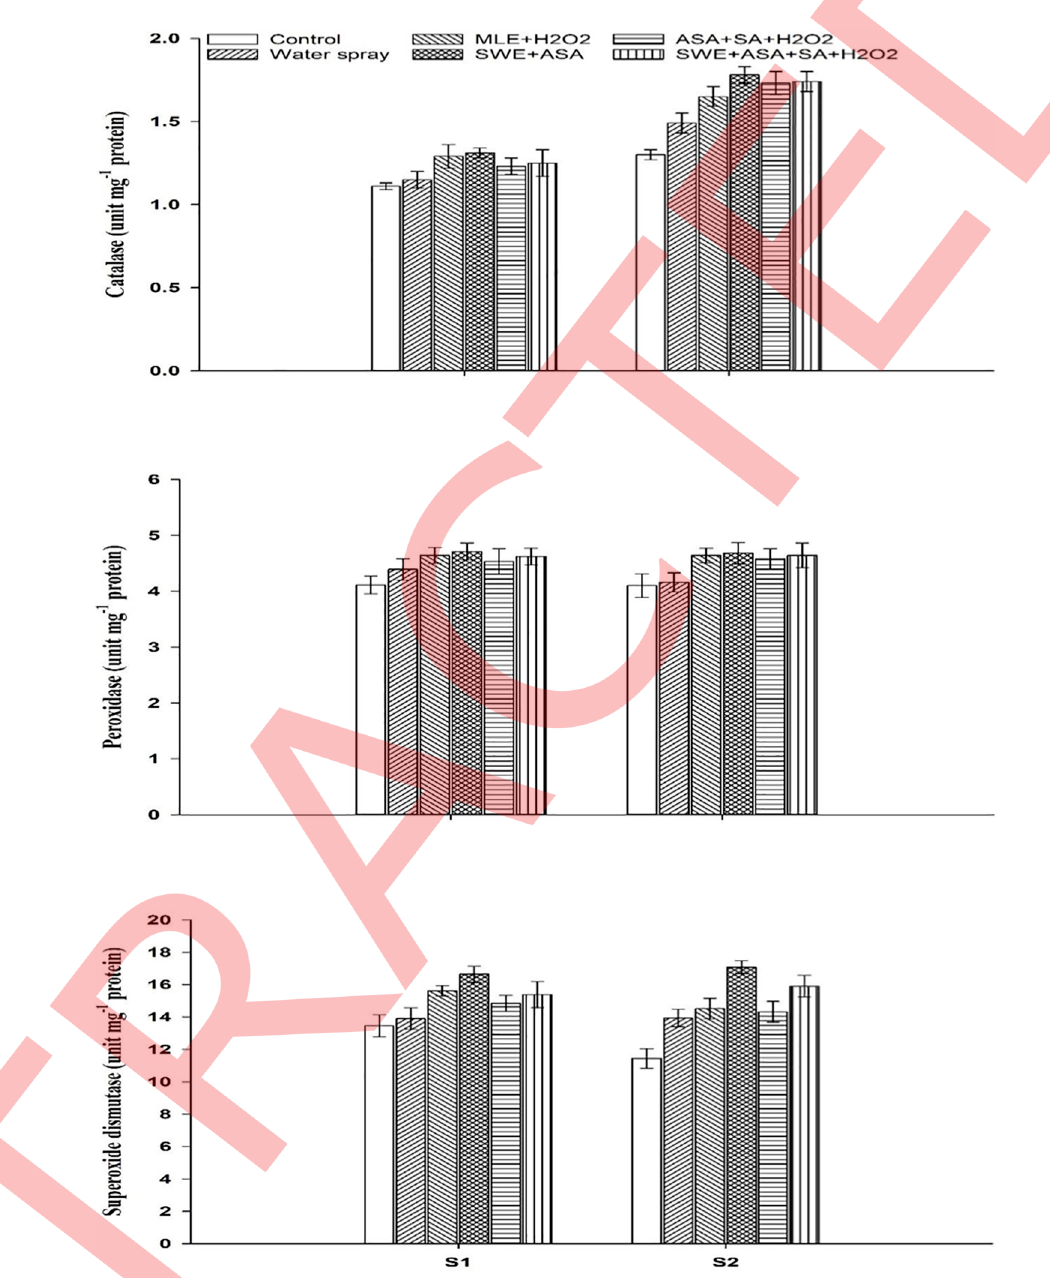
Fig 4. Antioxidant enzymes of maize influenced by foliar applied growth promoting agents and sowing dates.